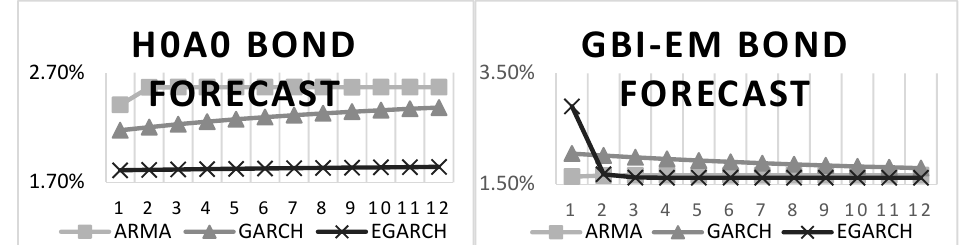
Figure 18. Bonds model forecasts (12 months). Source: authors.